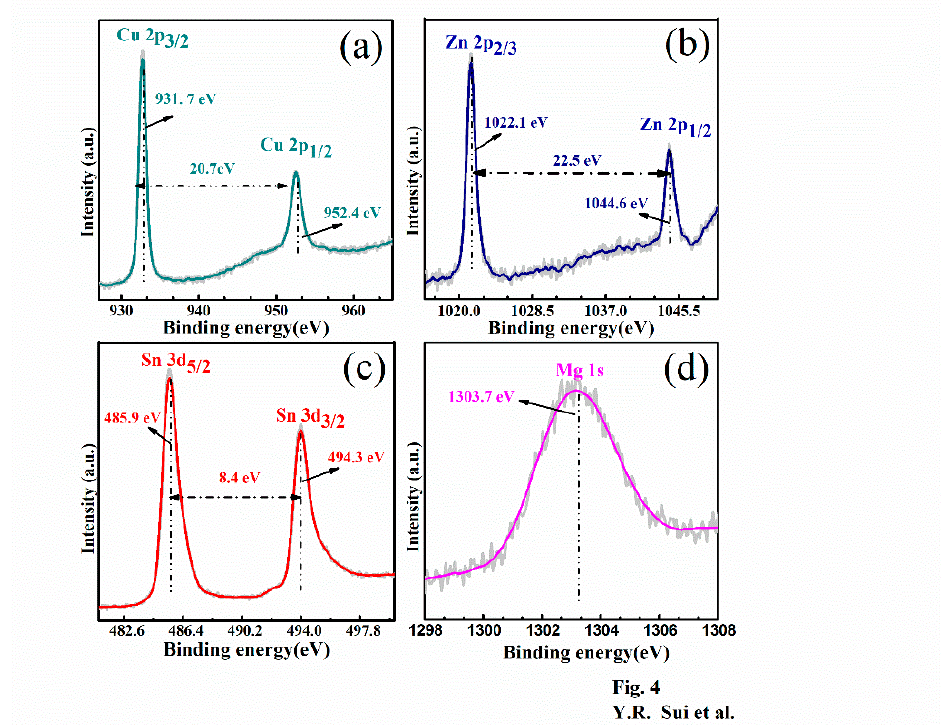
Figure 4. X-ray photoelectron spectroscopy (XPS) spectrum of Cu 2 Mg x Zn 1 − x SnS 4 ( x = 0.2) thin films: ( a ) Cu, ( b ) Zn, ( c ) Sn and ( d ) Mg.